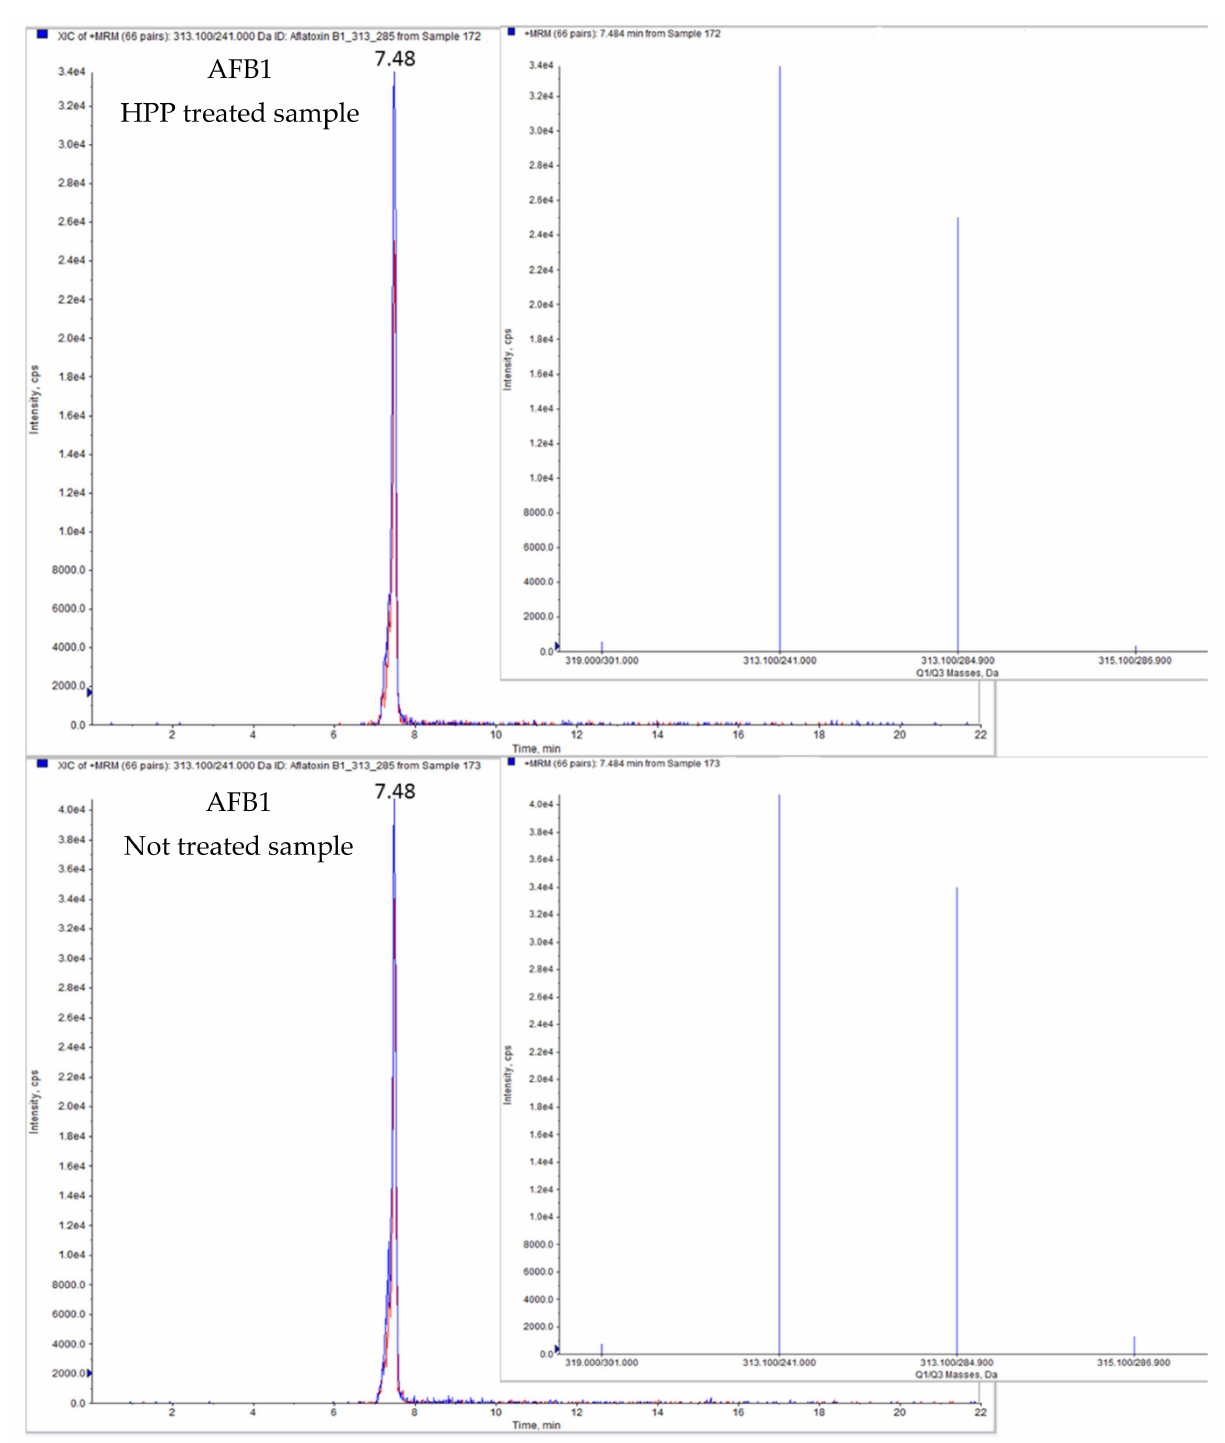
Figure 1. LC-MS/MS-IT chromatogram of grape juice sample contaminated by AFB1 treated by HPP vs. non-treated. Concerning Alternaria mycotoxins (AOH and AME), Ioi [33] studied the effect of thermal processing (90 or 121 ◦ C for 10 or 20 min) and HPP treatment (300 or 600 MPa for 3 or 5 min) on AOH and AME spiked at concentrations of 80, 200, and 500 µ g/kg in fresh tomato juices. Thermal treatment resulted in reductions of AOH ranging from 0.9% to 14.5% and AME from 1.0% to 15.3%, while HPP treatment produced reduction percentages in a range comprised between 5.8% and 25.3% for AOH and between 1.7% and 12.9%